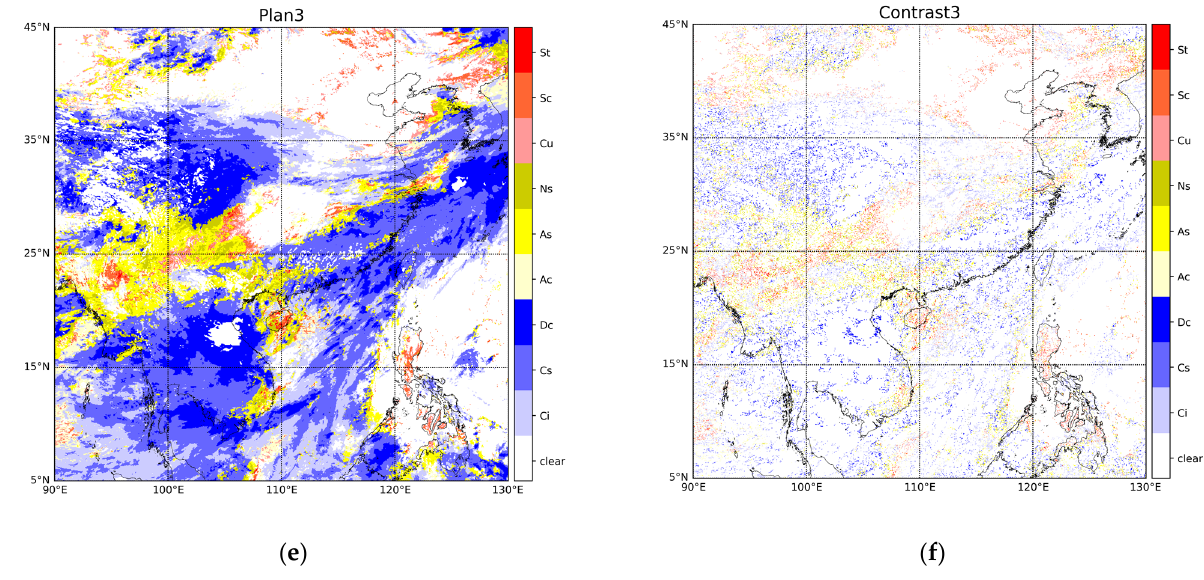
Figure 10. ( a ) The output of Plan 1; ( b ) different points between Plan 1 and Himawari-8; ( c ) output of Plan 2; ( d ) different points between Plan 2 and Himawari-8; ( e ) output of Plan 3; ( f ) different points between Plan 3 and Himawari-8; (Example time 3 July 2019). Table 3. The results of the three plans compared with the Himawari-8